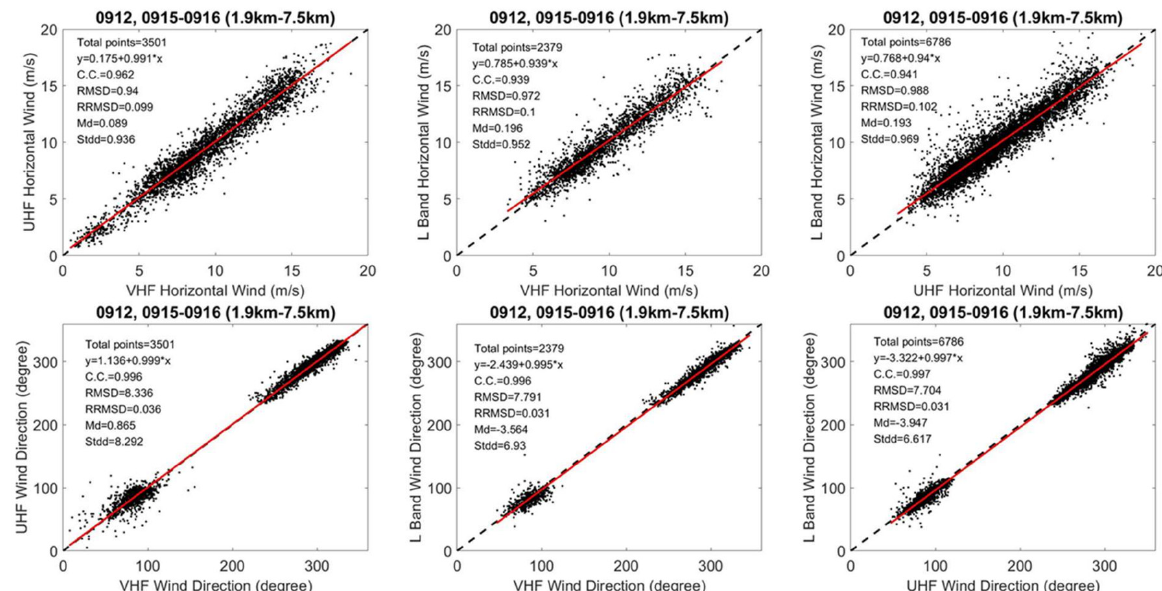
Figure 5. Scatterplots of horizontal wind velocities ( upper ) and wind directions ( lower ) between different pairs of wind profiler measurements in clear air conditions. The dashed black line is the diagonal line, and solid red line is the regression line best fit to the